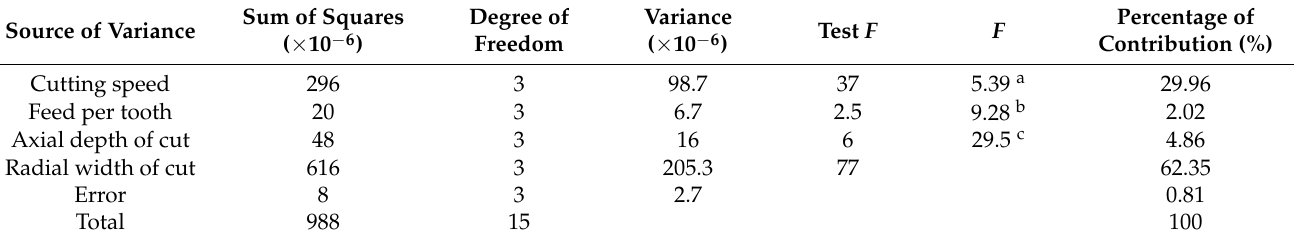
Table 3. Analysis of variance for energy consumption per unit of